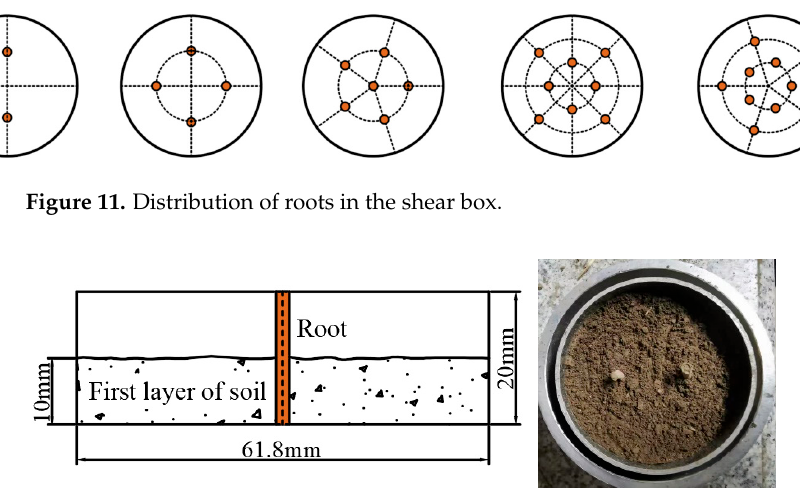
Figure 10. ( a ) Organic glass block with root epidermis ( b ) Test specimen of root–soil interface bond strength after compaction. Table 2. Number of specimens for bond strength of root–soil interface.